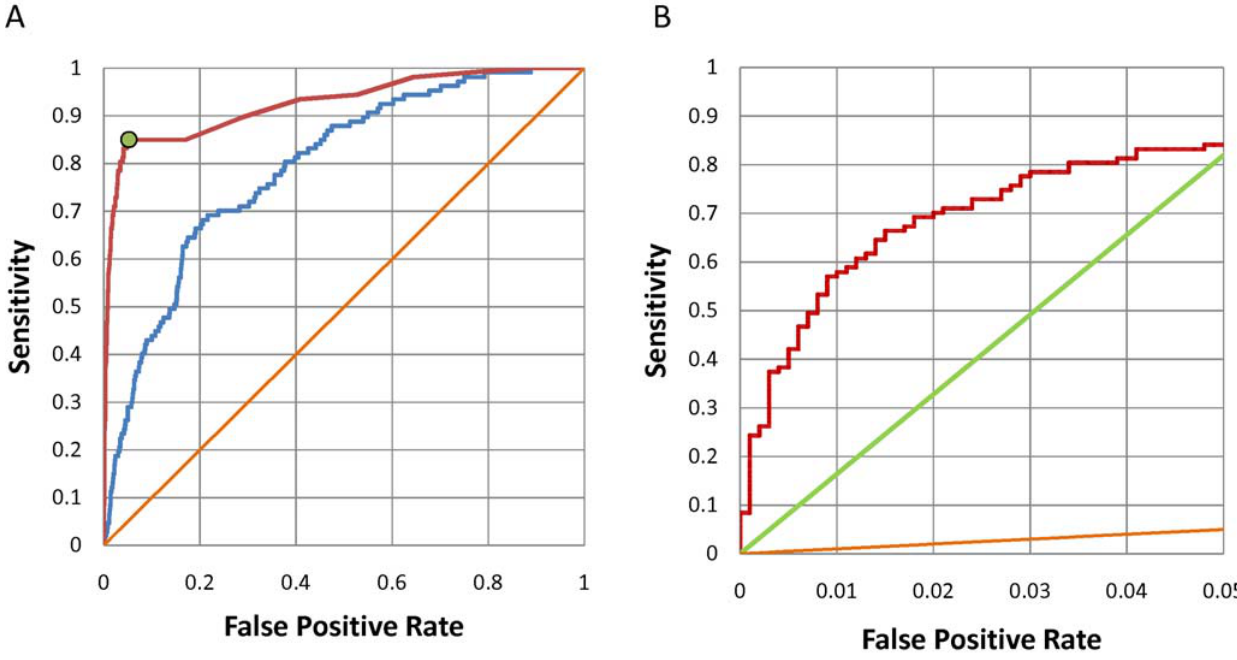
Figure 4. Prediction of SH2-mediated protein-protein interactions using FoldX, phosphorylation, and secondary structure information. (A) FoldX predictions for all nine domains in Table 1 (blue line), predictions using FoldX and the phosphorylation/secondary structure filter (red line), predictions using the phosphorylation/secondary structure filter only (green point), and random prediction (orange line). (B) Detail of the low false positive rate region of (A), with predictions using the phosphorylation/secondary structure filter (green curve) and both the filter and FoldX (red curve).